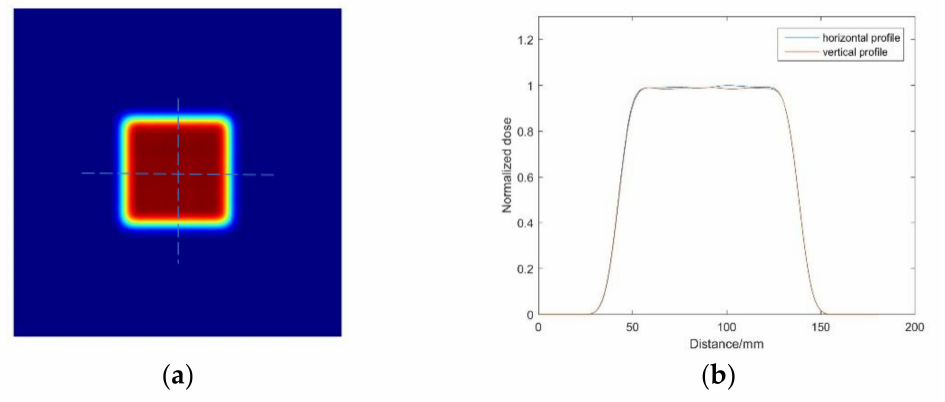
Figure 4. ( a ) Reconstructed proton dose map of incoming energy 83.8 MeV at depth 2 cm and ( b ) lateral dose